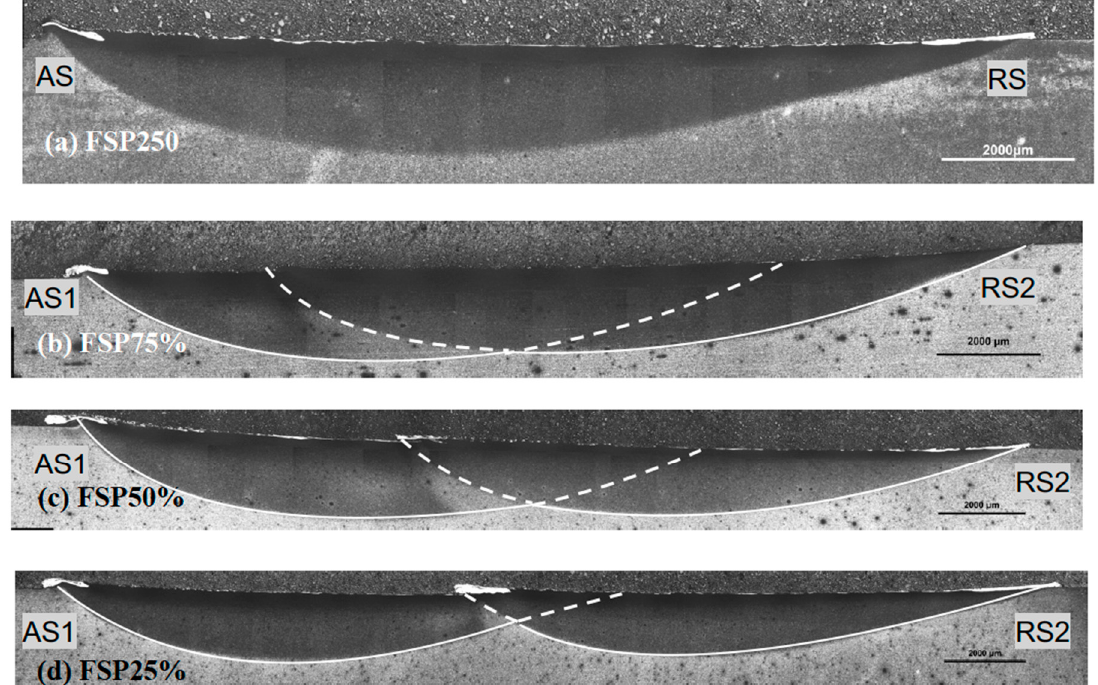
Figure 2. Optical micrographs of the cross-sections of FSPed AISI 420 with various overlapping ratios: ( a ) FSP250; ( b ) FSP75%; ( c ) FSP50%; and ( d ) FSP25%.